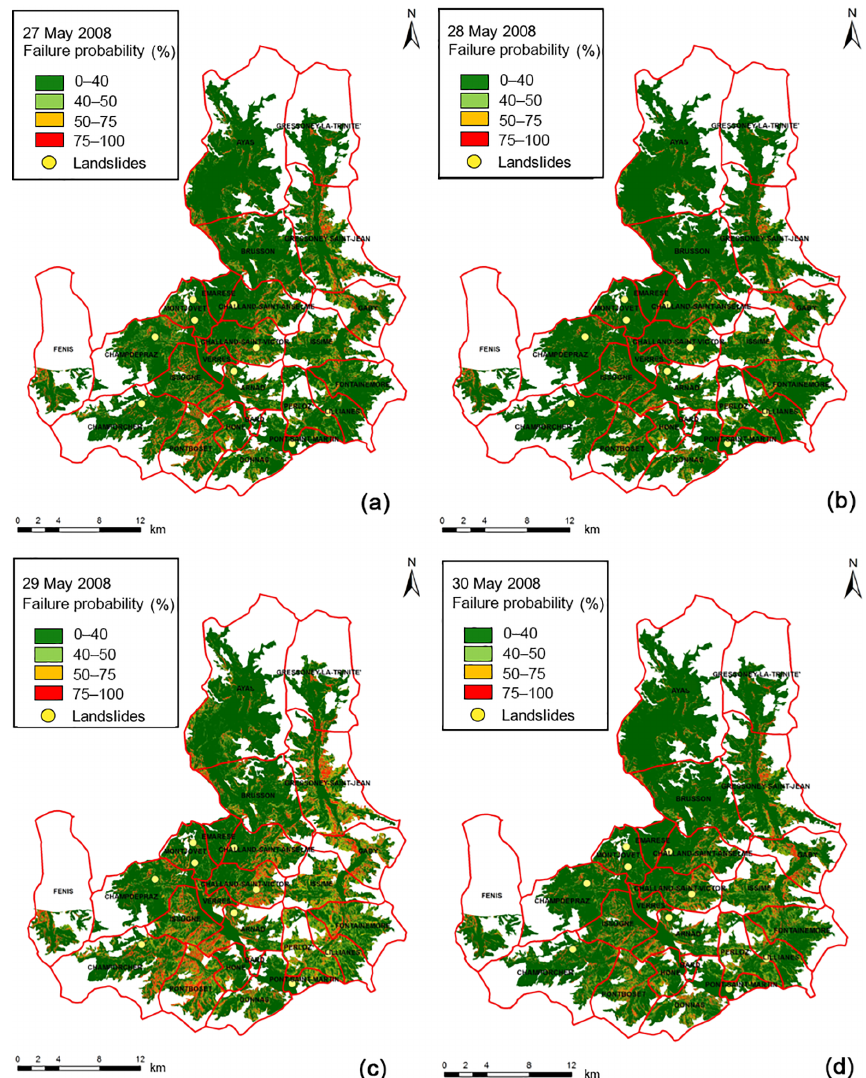
Figure 8. HIRESSS landslide probability maps of the simulated event from 24 to 31 May 2008 and the reported landslides during this event, with on the four critical days: (a) 27 May 2008, (b) 28 May 2008, (c) 29 May 2008, and (d) 30 May